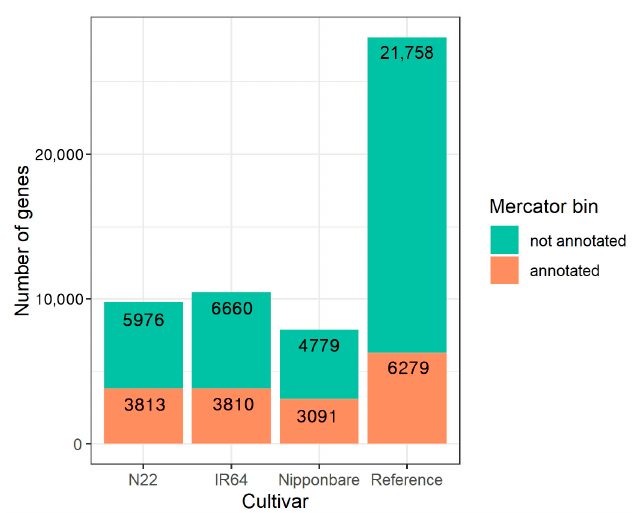
Figure A4. Number of genes classified as “annotated” or “not annotated” among the genes not assigned to a functional bin in the Mercator ontology for rice. Data are shown for the transcriptomes of N22, IR64 and Nipponbare and the Nipponbare reference transcriptome.